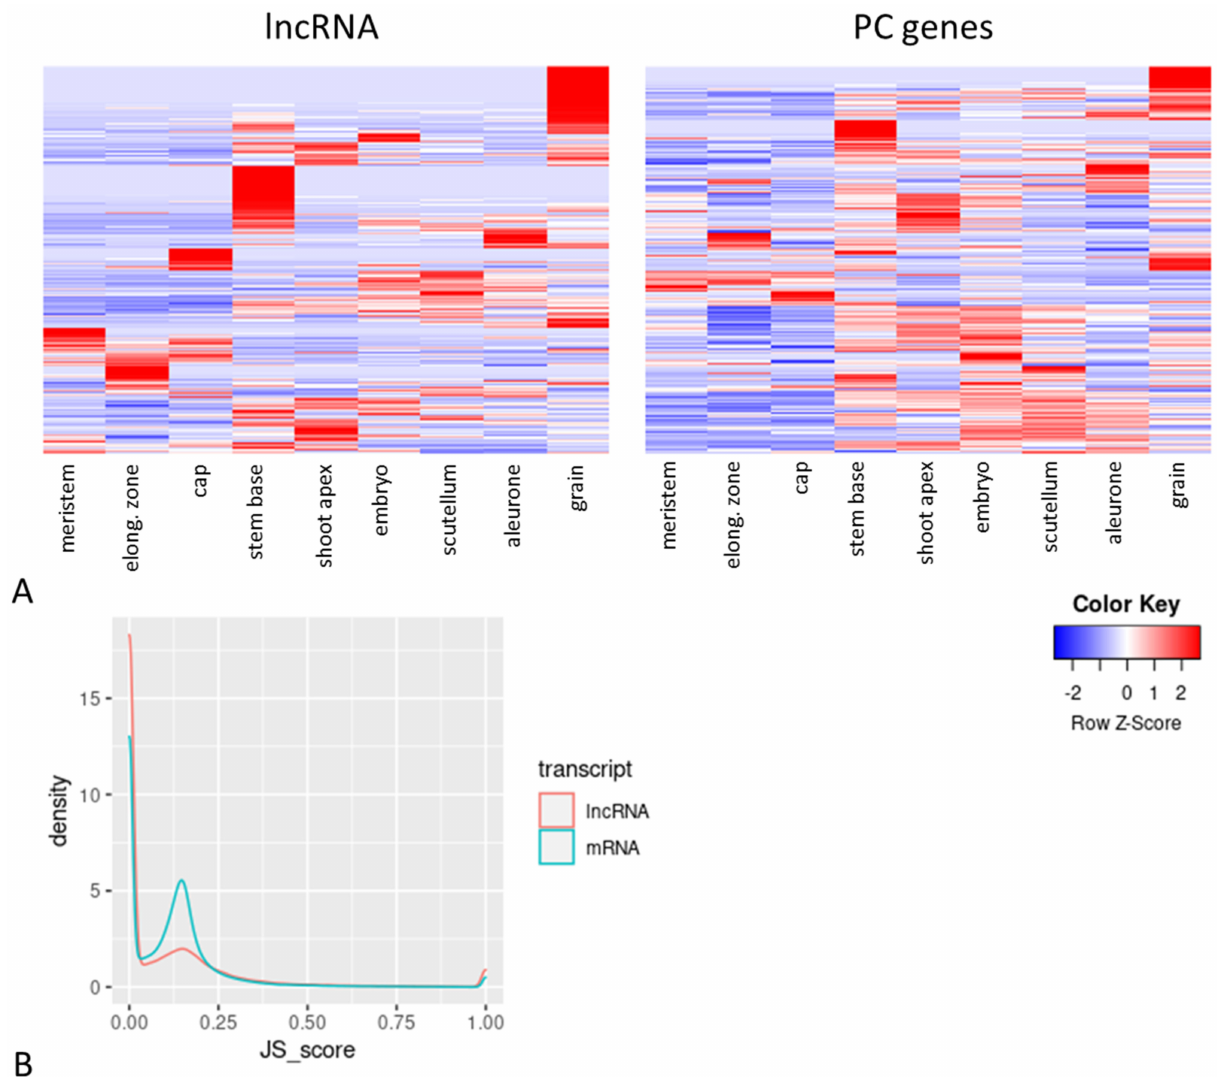
Figure 4. Evaluation of tissue specificity of lncRNA expression. ( A ) Expression patterns of lncRNAs and PC genes in nine different barley tissues; higher z–score (red colors) indicates higher tissue specificity; z–scores were calculated based on the mean FPKM values of each tissue. ( B ) Density plot of the JS–score calculated for PC genes and lncRNAs; JS–score 0 means no tissue specificity and 1 means unique expression in only one